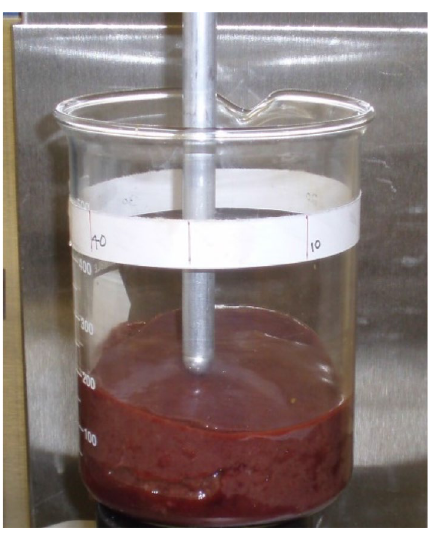
Fig. 2 Indention using spherical indenter